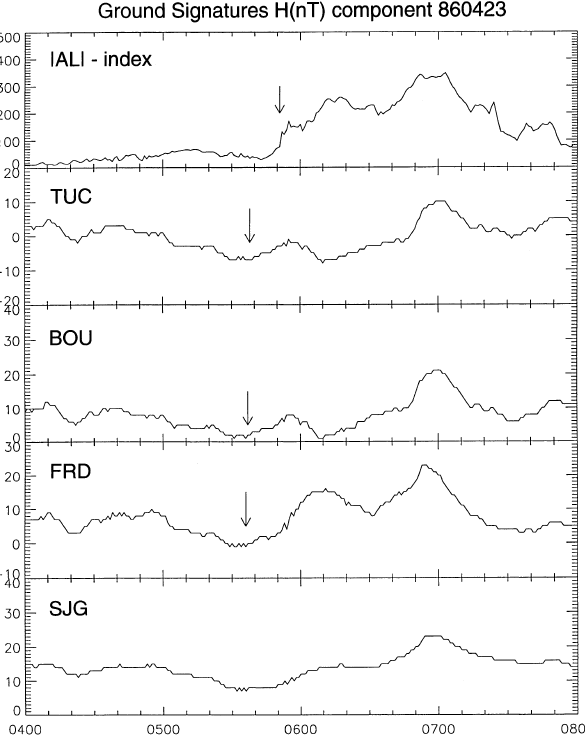
Fig. 1. The H-component magnetograms from four low-latitude stations, together with the AL index on April 23, 1986. The arrows indicate the onset time in